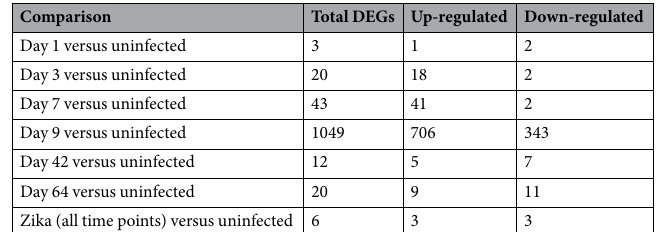
Table 2. Number of differentially expressed genes (DEG) between ZIKV-infected and uninfected marmosets by day post-inoculation.